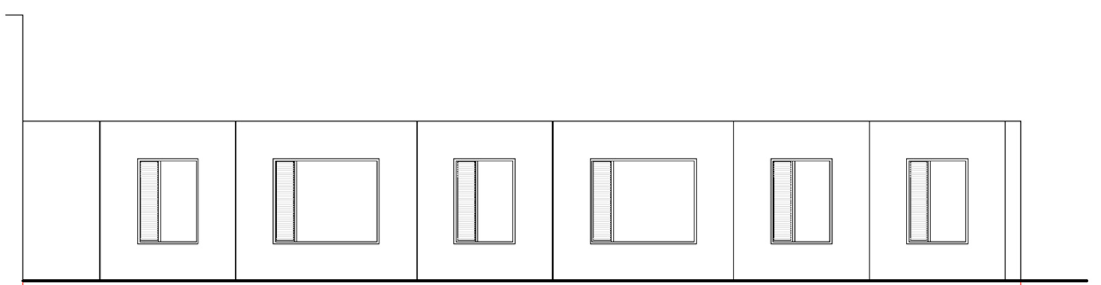
Figure 4. New recladding and overcladding panels on the renovated